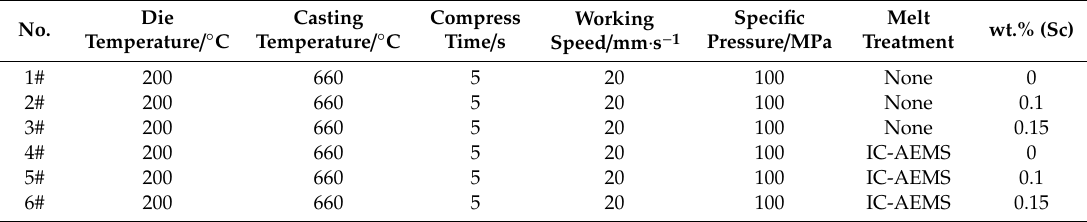
Figure 3. ( a ) Schematic diagram of the designed die; ( b ) schematic diagram of the forming part; ( c ) the actual die assembly and resistance heater. Table 2. Rheological die forging process parameters.